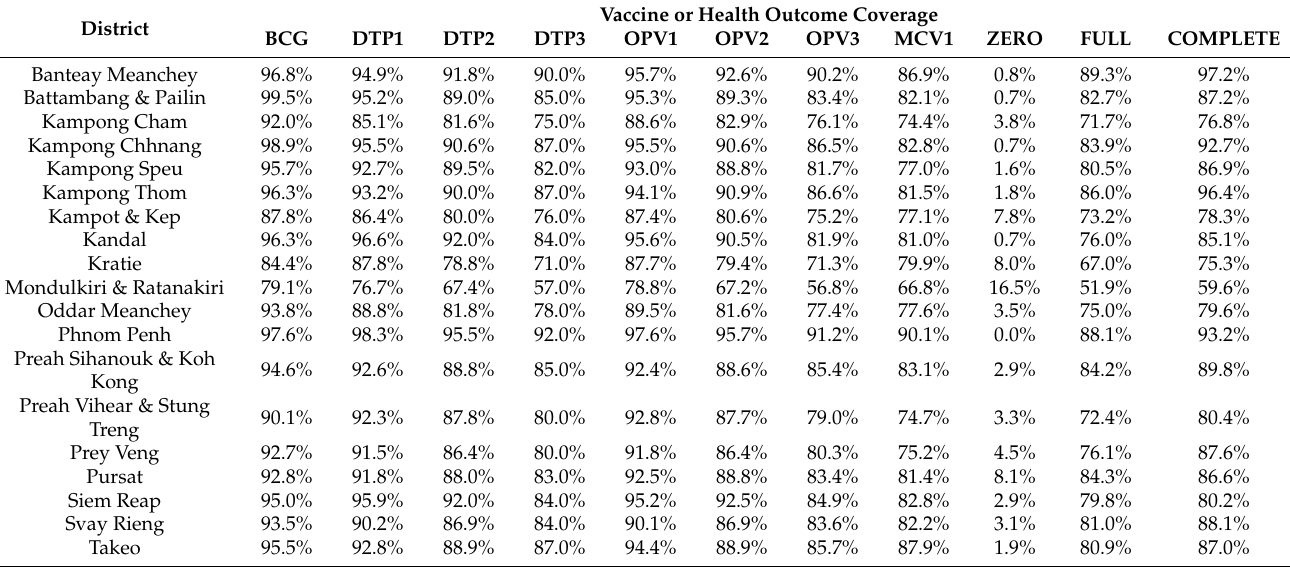
Table 2. Coverage/prevalence for individual districts and district pairs for national immunization program vaccines and vaccination statuses for survey year 2014.